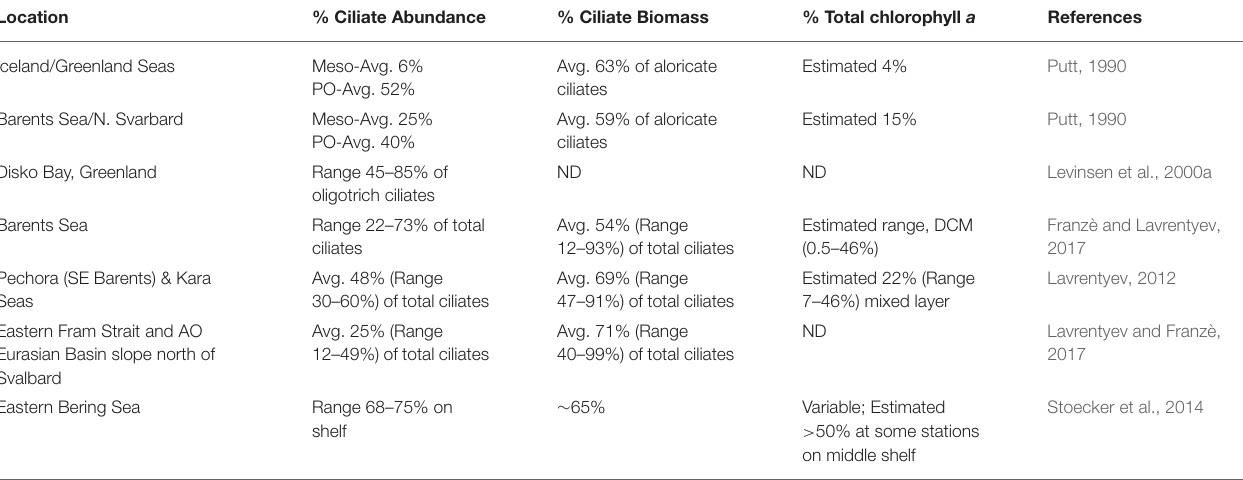
TABLE 3 | Relative contributions of mixotrophic ciliates to ciliate abundance, biomass, and total chlorophyll a (chl a ) in the Arctic during summer. Location